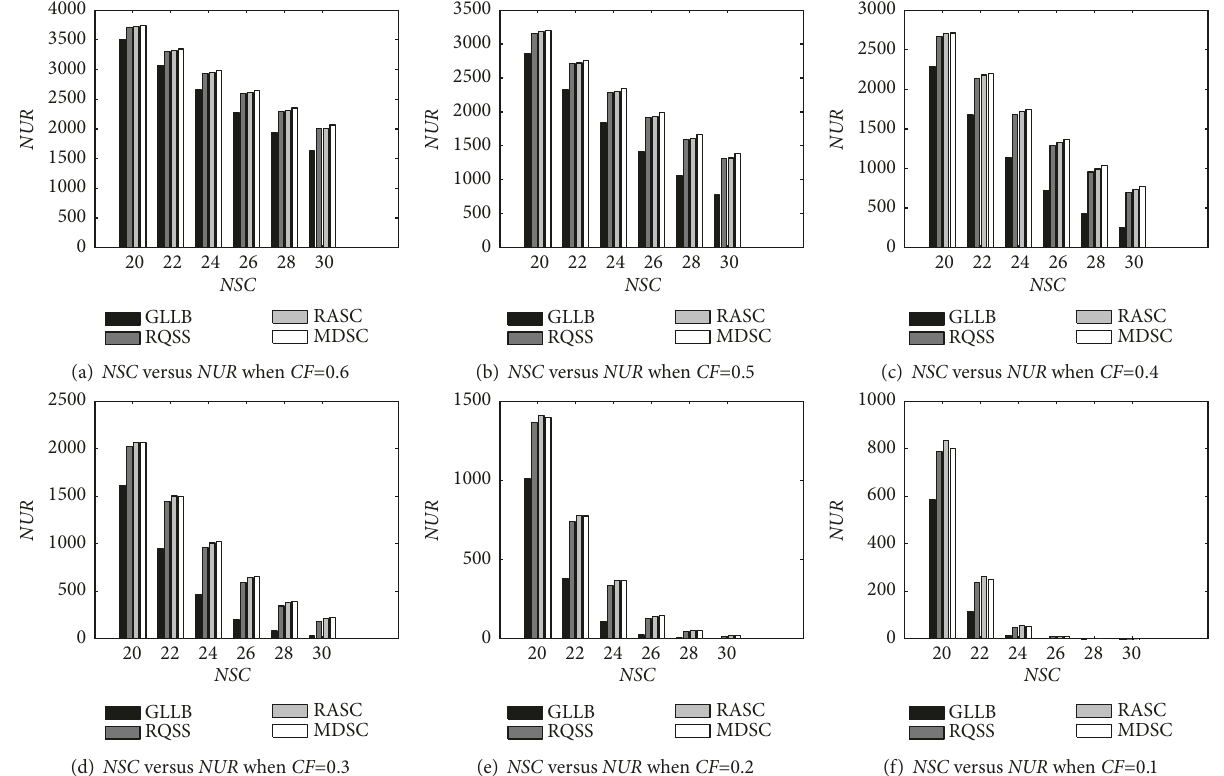
Figure 4: The number of unfinished web service requests.